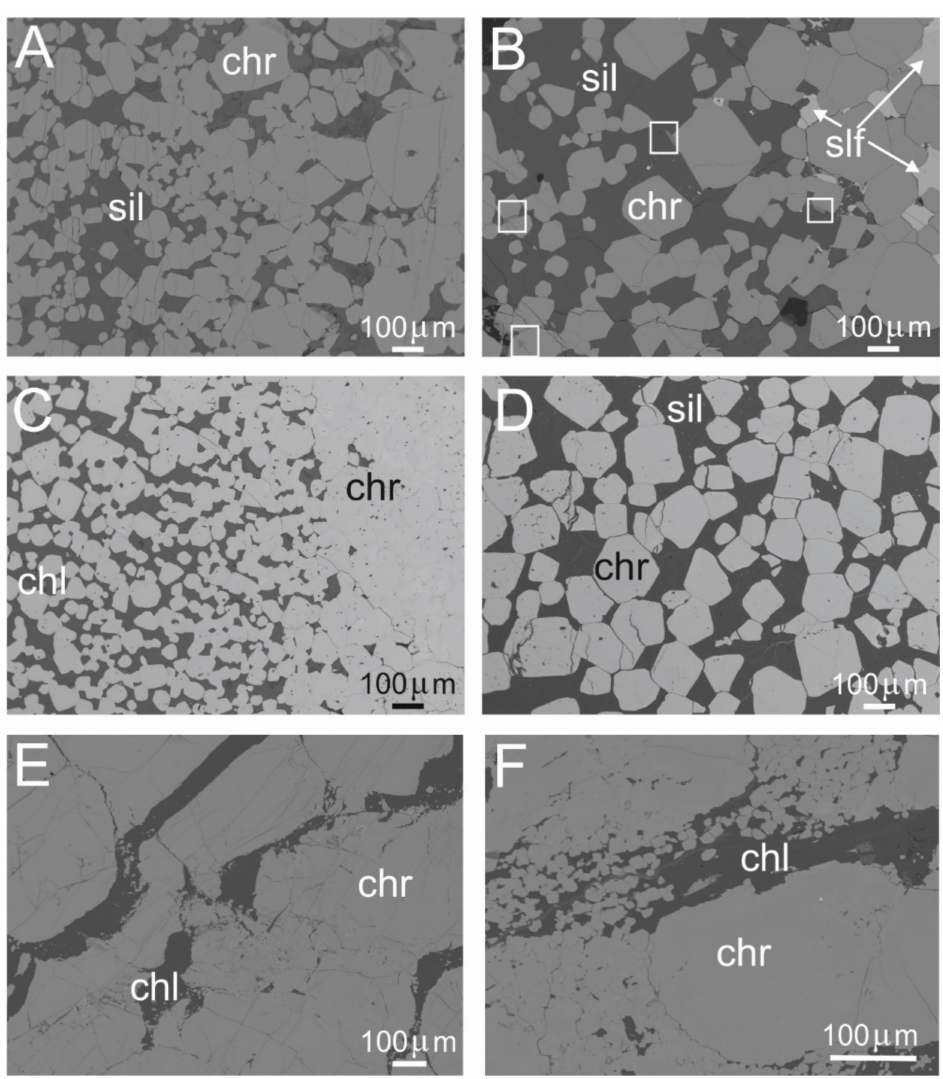
Figure 1. Back-scattered electron (BSE) images of chromite textures in unmetamorphic magmatic deposits. Cumulus textures showing transition from massive to high-grade disseminated chromite in UG2 ( A ), Merensky Reef ( B ), and Jacurici (sample JC96) ( C ). Equigranular cumulus chromite from Jacurici (sample JC150) ( D ). Massive fractured chromitite ( E ) and Massive chromitite with a cumulitic-like texture from Loma Peguera (sample LP4) ( F ). Boxes in B indicate position of rutile grains. Abbreviations: chr, chromite; sil, silicates; chl, chlorite; slf,